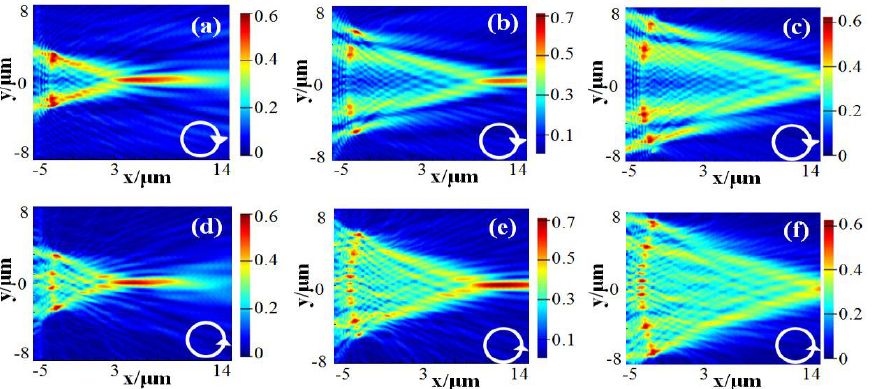
Figure 4. The simulated results of influences of the radius R of the ‘S’ on the near field electric field light intensity distributions z o = −200 nm for the cases of ( a , d ) R out = 9 μm, ( b , e ) R out = 16 μm and ( c , f ) R out = 21 μm. ( a – c ) for the simulated results of right − handed CPL incidence. ( d − f ) for the simulated results of left − handed CPL incidence. The amplitude of the incident light is set to 1.